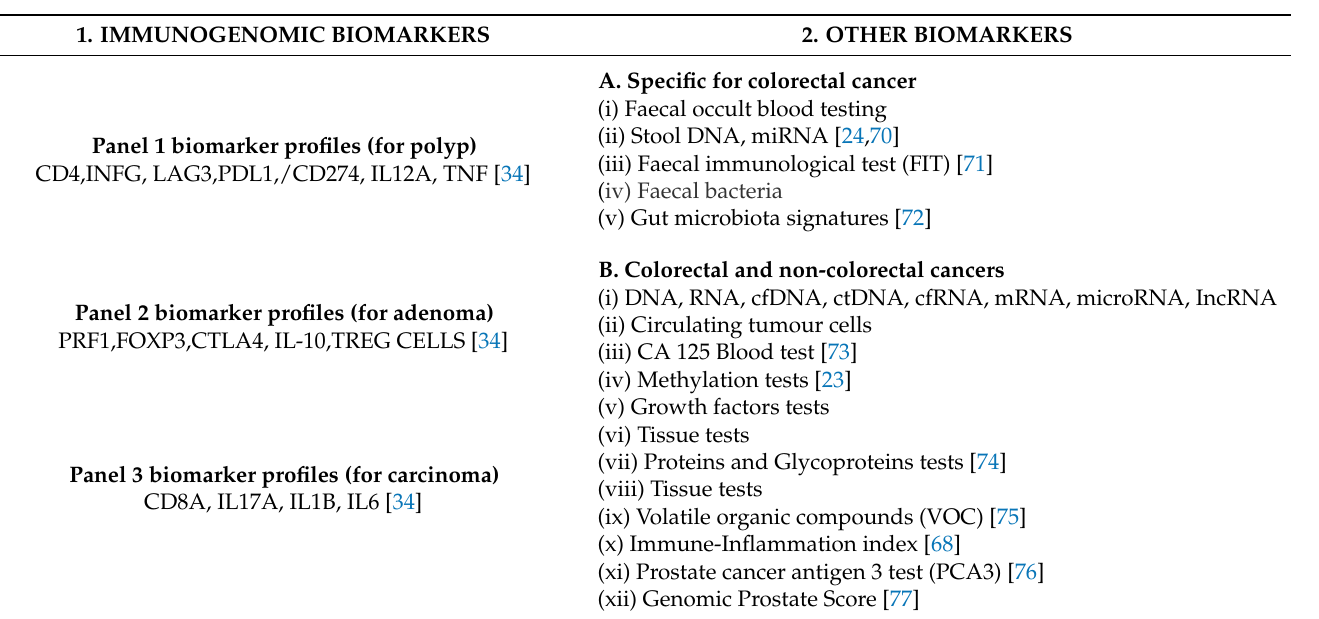
Table 1. Different panels of immunogenomic biomarkers and other diagnostic/prognostic biomarkers in